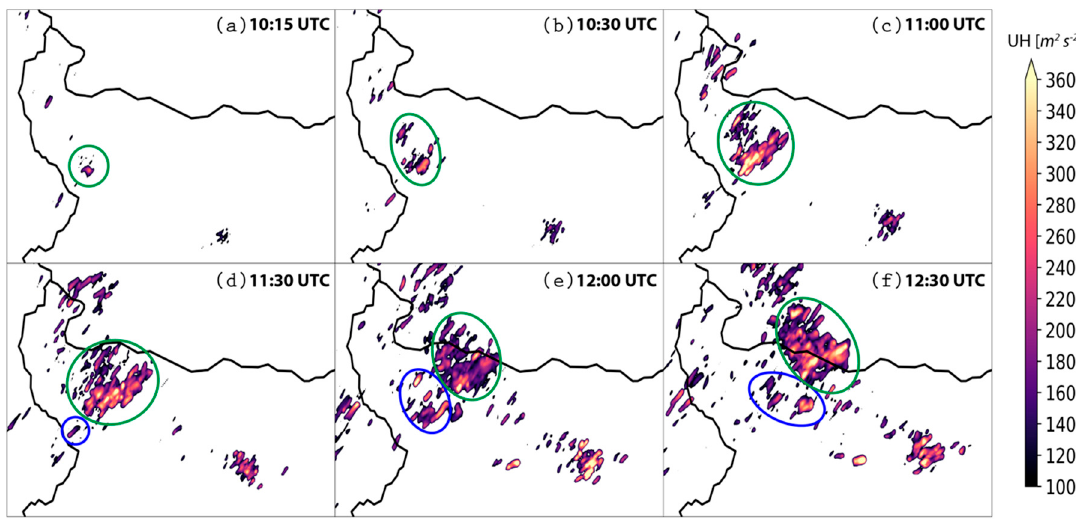
Figure 16. Clustering of the WRF ensemble forecasts with respect to the time of convection initiation (clusters denoted by green and blue ellipses). Color shading displays the ensemble maximum of hourly maximum 2–5 km UH at ( a ) 10:15 UTC, ( b ) 10:30 UTC, ( c ) 11:00 UTC, ( d ) 11:30 UTC, ( e ) 12:00 UTC and ( f ) 12:30 UTC.